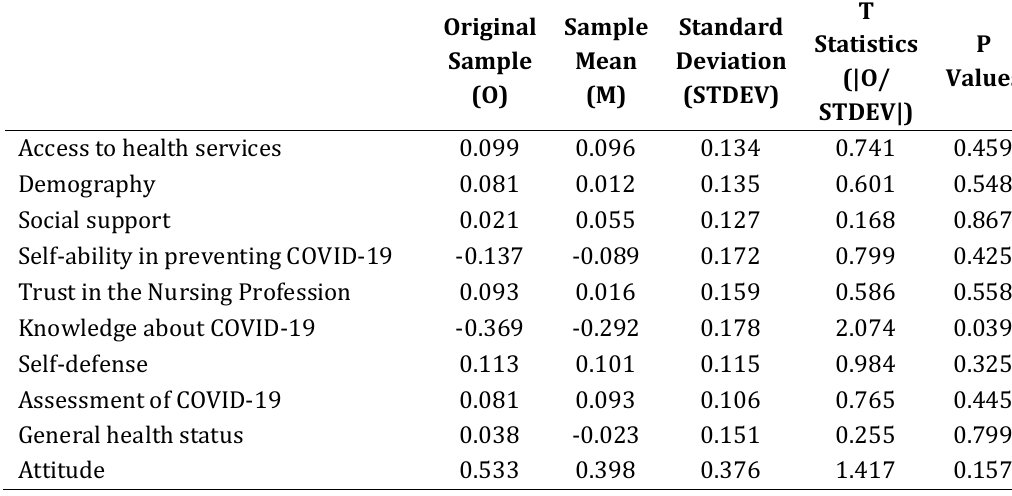
Factors that influence COVID-19 prevention behaviour in the older adults group